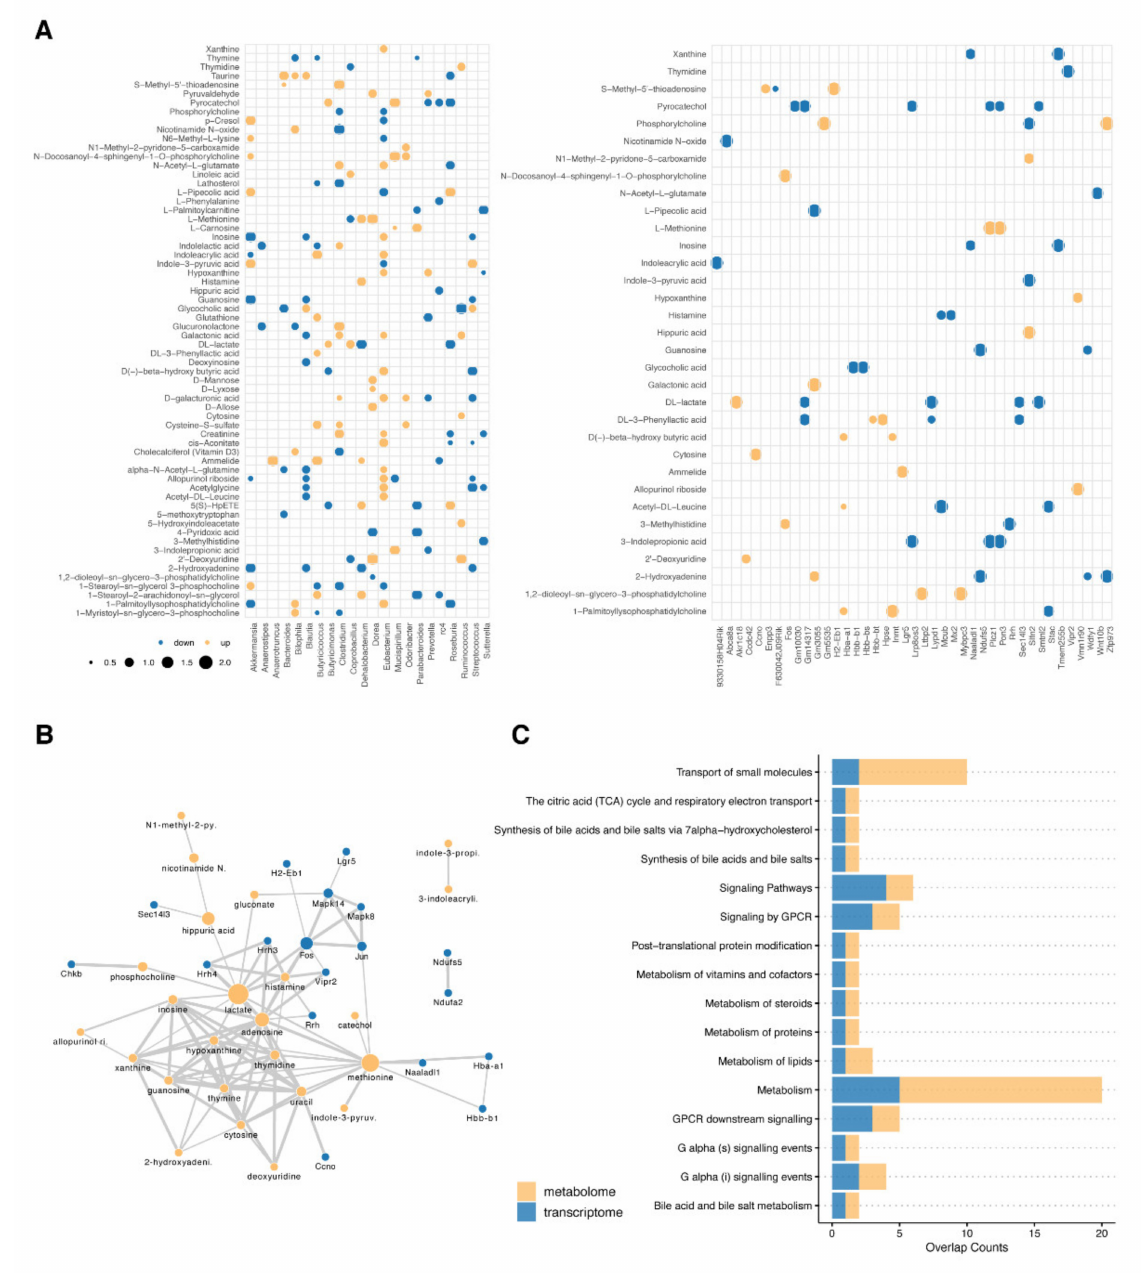
Figure 8. Integration of correlation analysis for metabolites–microbes and metabolites–genes. ( A ) Scat- ter plots for the alteration of correlation coefficients. Compared to wt mice, red represents an increase in the correlation coefficient, while blue represents a decrease. The size of the dots represents the absolute value of the change in correlation coefficients. ( B ) Interaction network of selected metabolites and genes based on STITCH database. The color of each node represents the classification of each selected feature. The size of the node represents the betweenness centrality. The thickness of each edge represents the interaction strengths between nodes. ( C ) Bar graph for Over-representation analysis (ORA) of selected metabolites and genes based on the Reactome